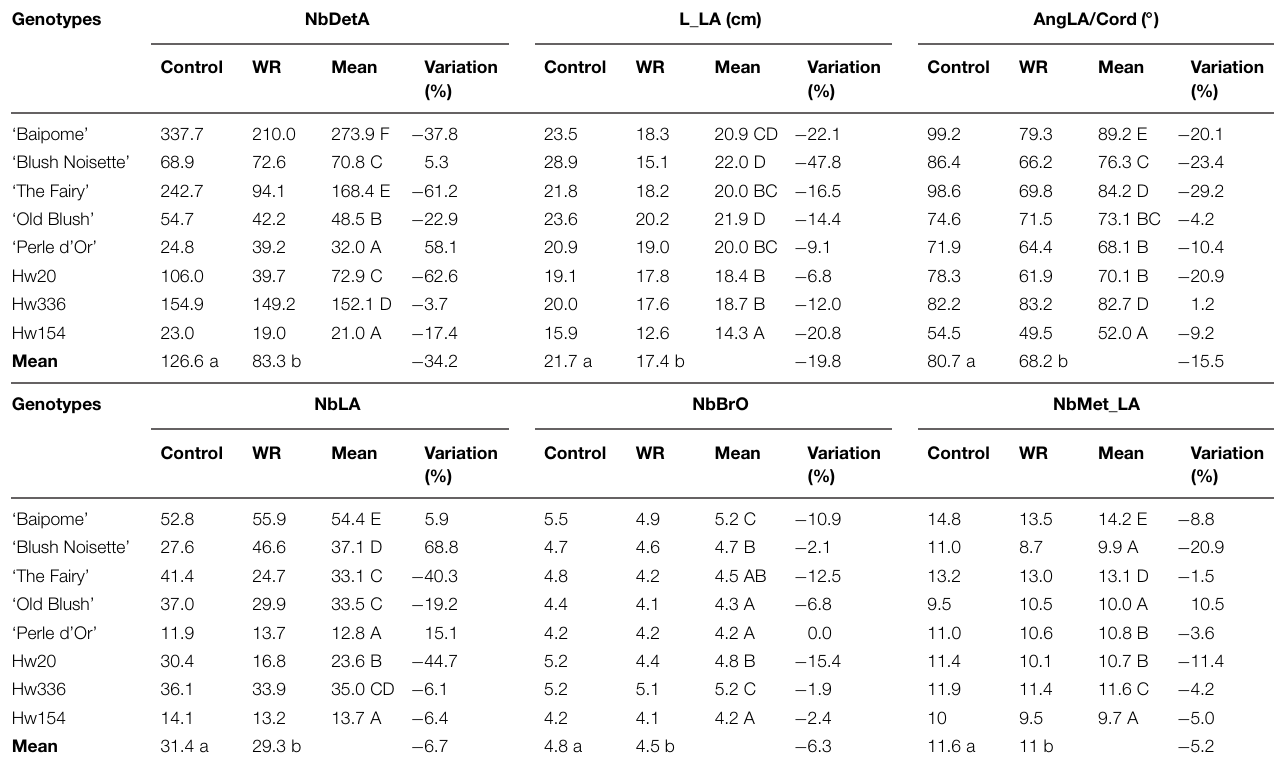
TABLE 1 | Mean of six architectural variables measured on control plants and plants subjected to a water restriction (WR) treatment of eight rose genotypes.